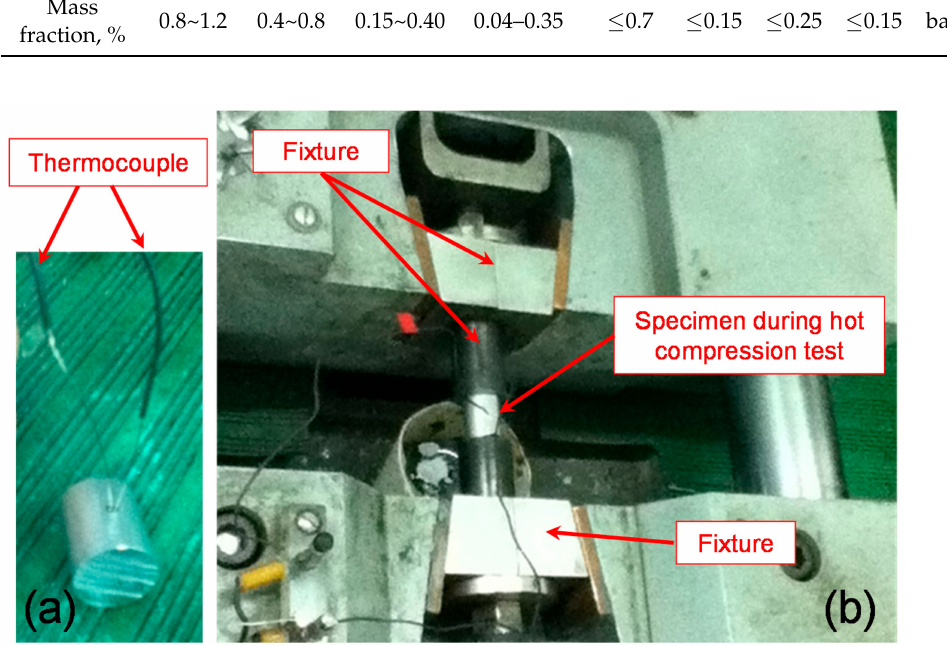
Figure 1. Specimen and configuration of the hot compression tests. ( a ) The cylinder specimen is connected with a thermocouple before the tests; ( b ) The configuration of the